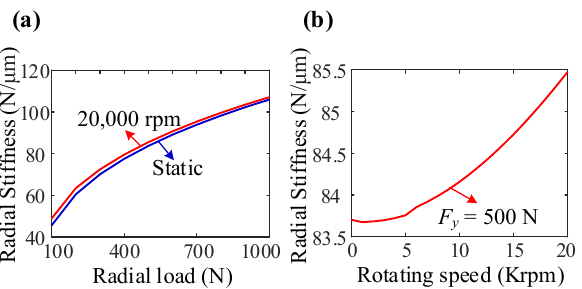
Figure 8. The radial stiffness variation for ball bearing one-direction pure radial load: ( a ) the radial stiffness changes against the radial force; ( b ) the radial stiffness changes against the rotating speed.